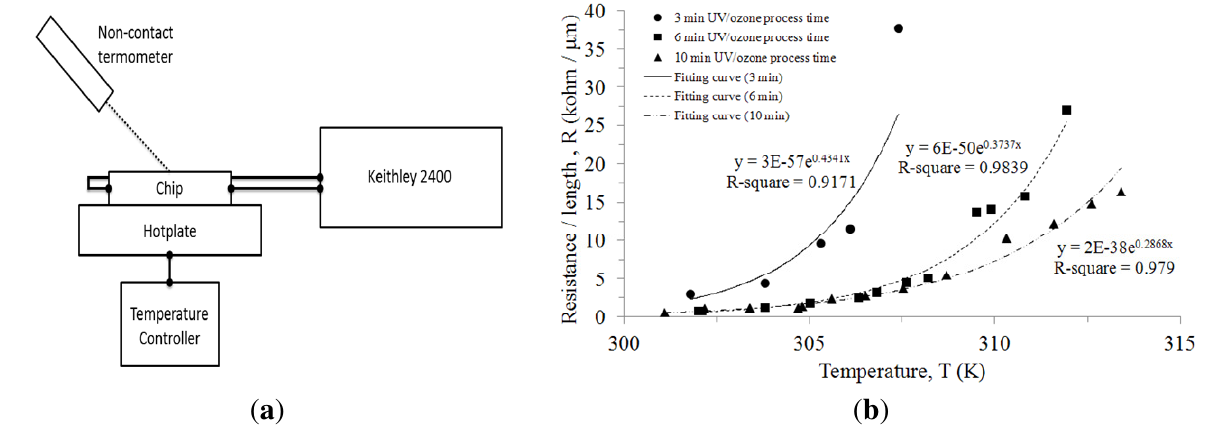
Figure 6. ( a ) TCR measurement setup, and ( b ) the cytochrome c thin film resistance